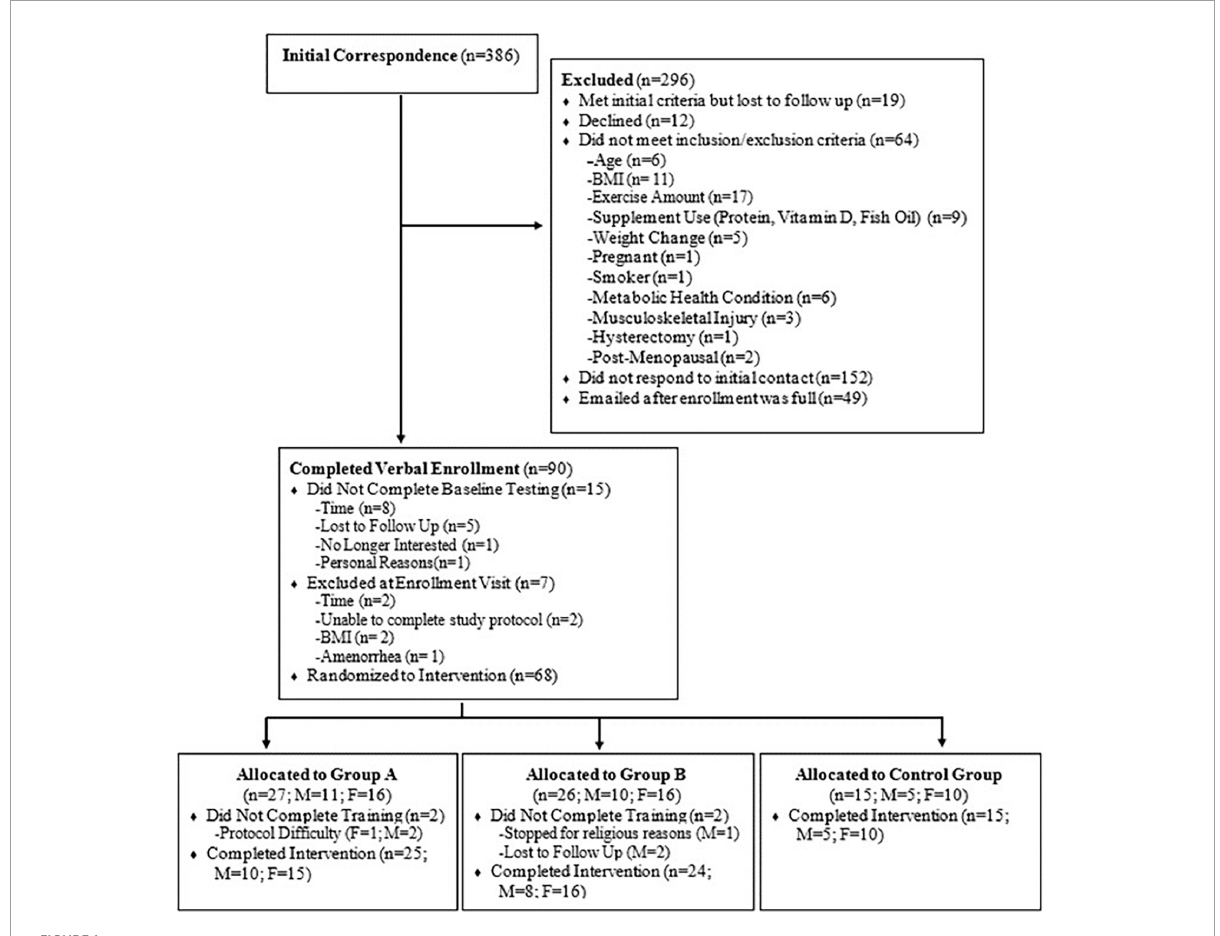
FIGURE1 CONSORT